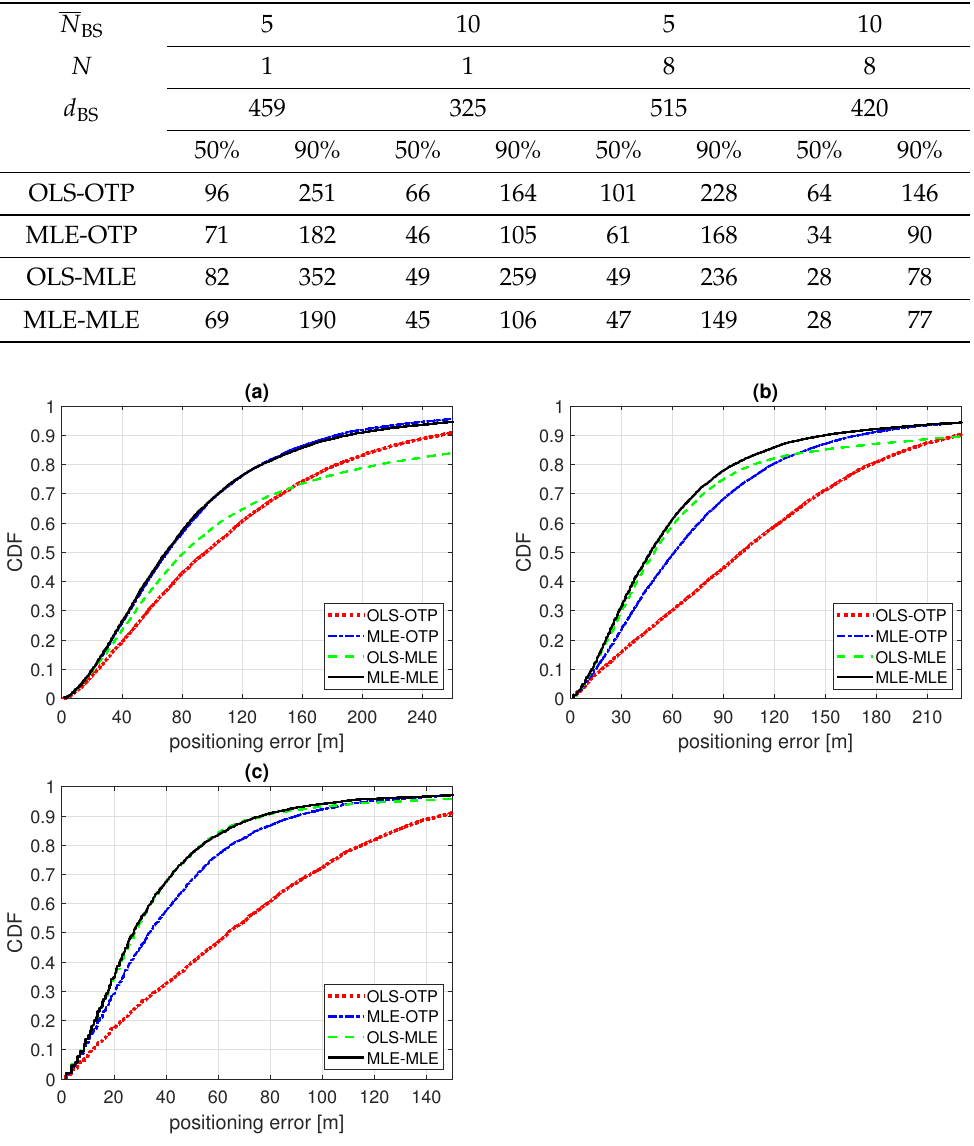
Figure 8. CDF of positioning error of Example 2. Model fitting to training data with ordinary least squares (OLS-) or Tobit MLE fitting (MLE-) and positioning with either ordinary trilateration (-OTP) of Tobit MLE positioning (-MLE). ( a ) N = 1, N BS = 5; ( b ) N = 8, N BS = 5; ( c ) N = 8, N BS = 10. The relative performances of OLS-OTP, MLE-OTP, OLS-MLE, and MLE-MLE are the same as in Example 1. Using MLE in either case reduces the positioning errors; OLS-OTP is the worst and MLE-MLE is the best method. For example, in the case of N BS = 5 and omnidirectional BS antennas, the improvement in median error is 35% or 28% for Examples 1 and 2, respectively. The errors are larger in Example 2 than in Example 1 due to larger σ / α , i.e., larger standard deviation of the expected log-distance (19). The improvement from OLS-OTP to MLE-MLE ranged from 28% (from 96 to 69 m with N = 1 and N BS = 5) to 57% (from 64 to 28 m with N = 8 and N BS = 10) for the median error and from 24% (from 251 to 190 m with N = 1 and N BS = 5) to 47% (from 146 to 77 m with N = 8 and N BS = 10) for the 90th